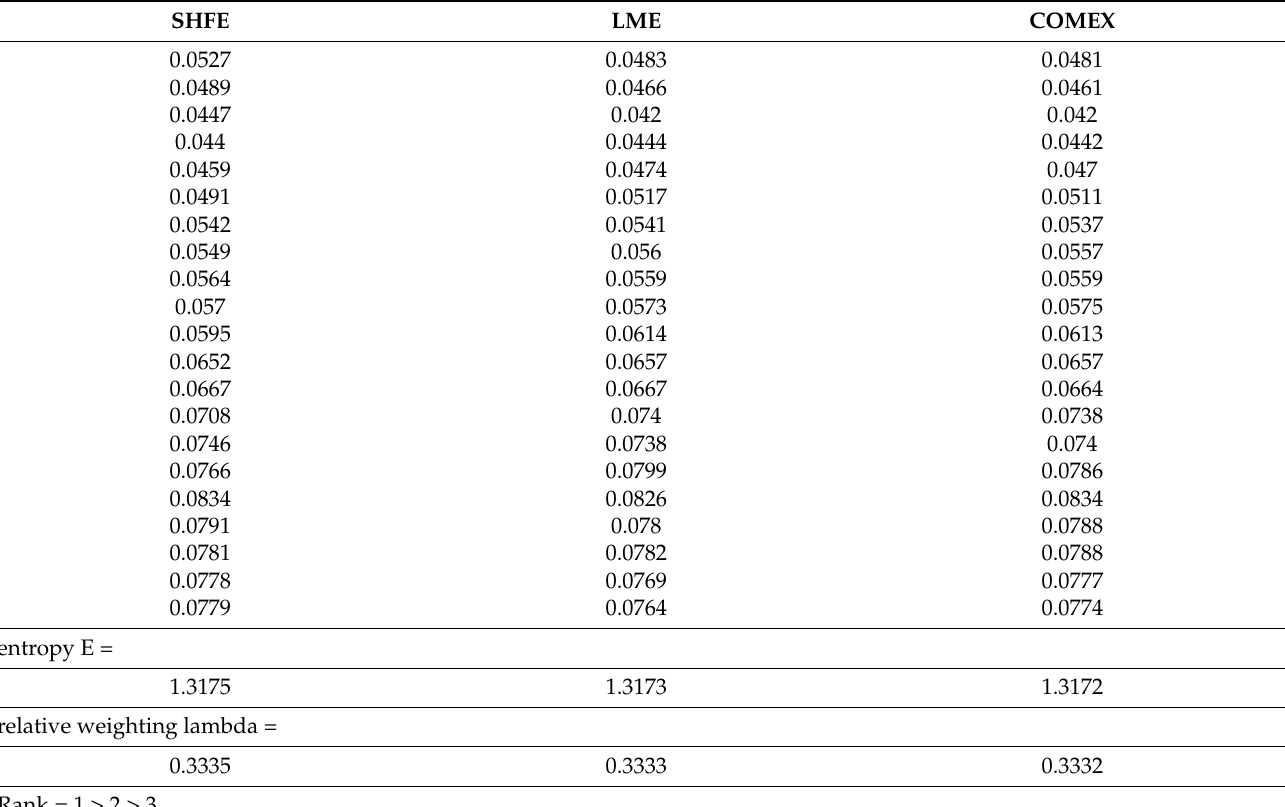
Table 4. Values from the processing of each factor after weighted analysis using grey entropy after the COVID-19